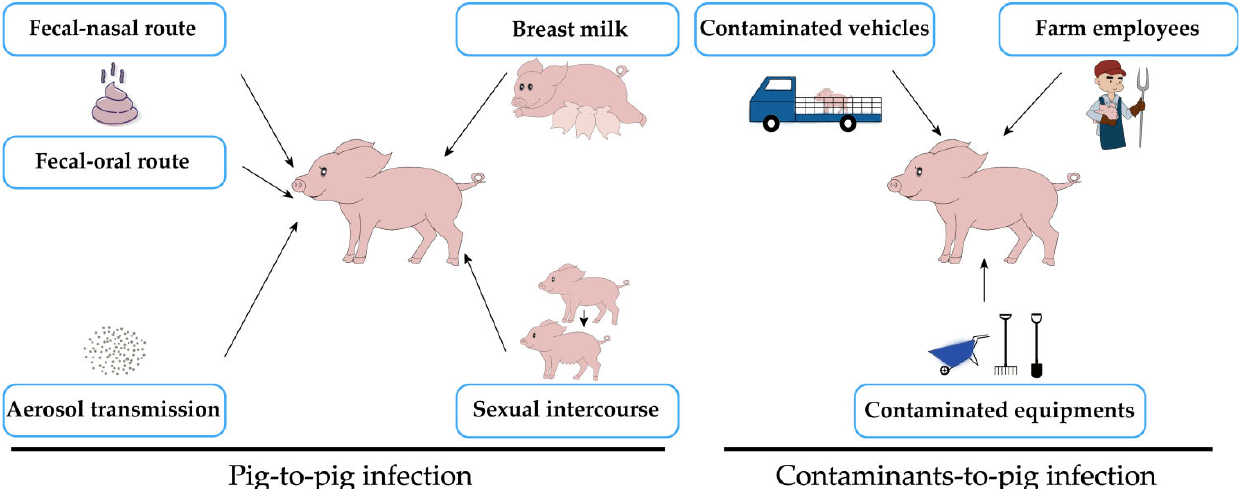
Figure 1. Several transmission routes of PEDV infection. Black arrows indicate transmission routes of PEDV.